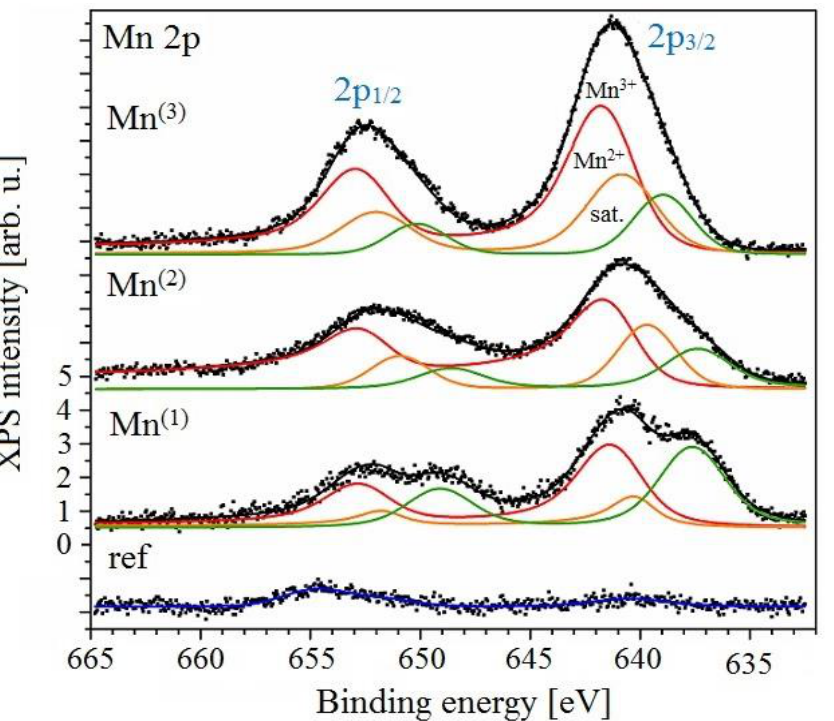
Figure 30. XPS spectrum of spectral region Mn 2p from all exposure—background subtracted from all spectra.